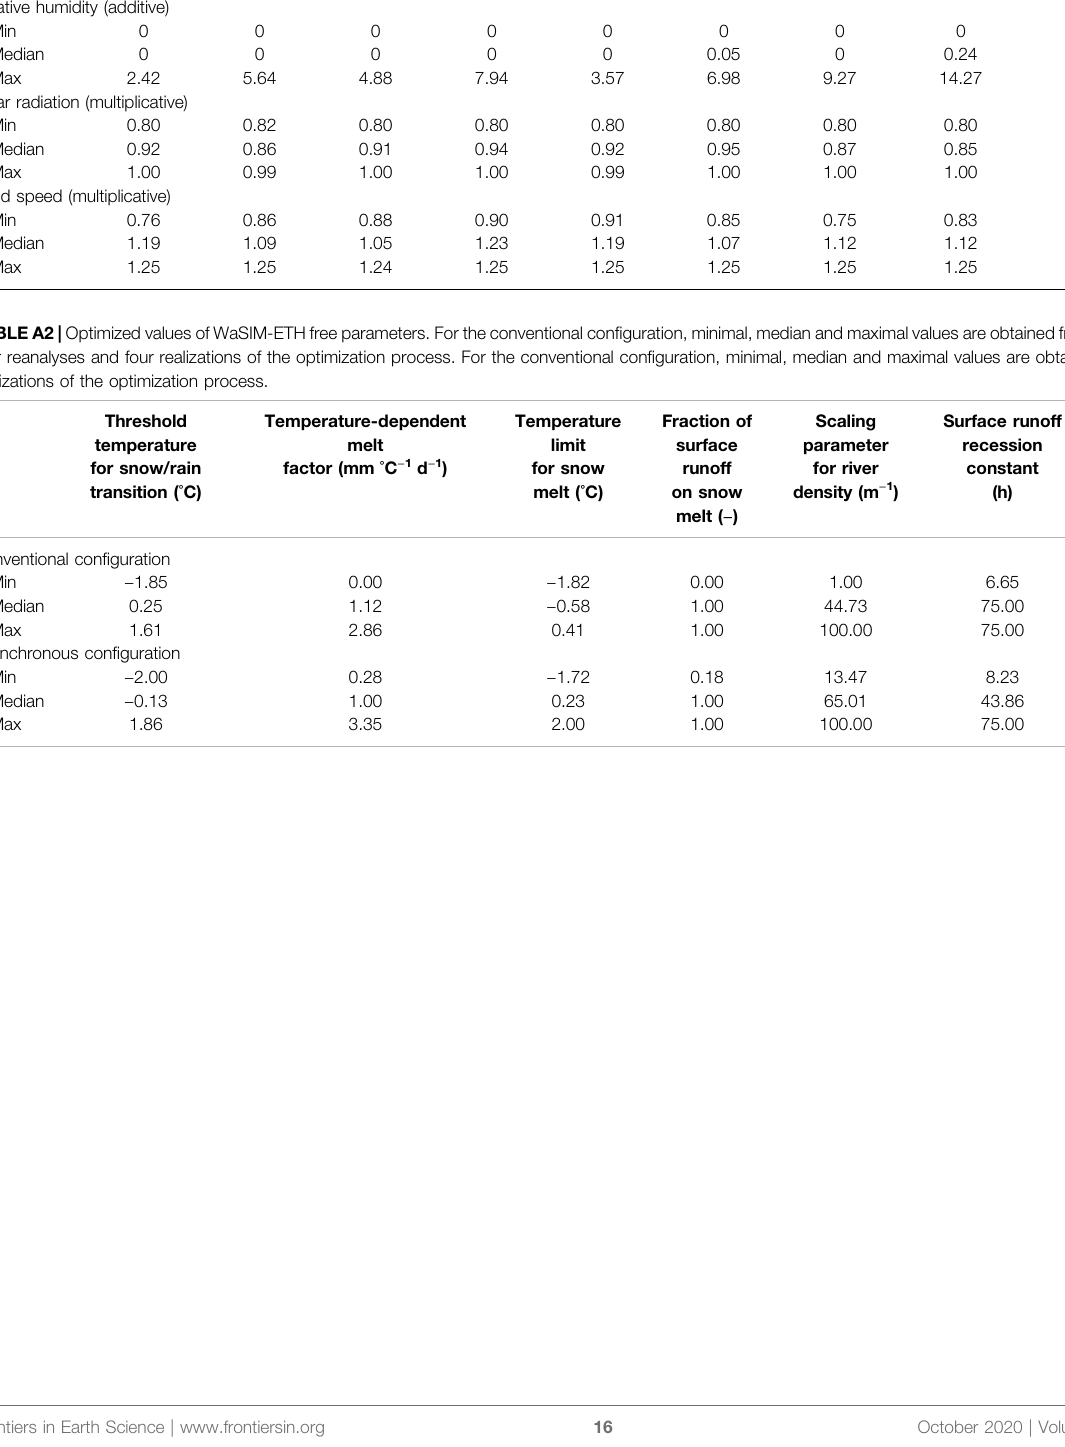
TABLE A1 | Transfer function quantile values for relative humidity, solar radiation, and wind speed optimized by the asynchronous con fi guration. Minimal, median and maximal values are obtained from 16 realizations of the optimization process. q 05 Relative humidity (additive) Min